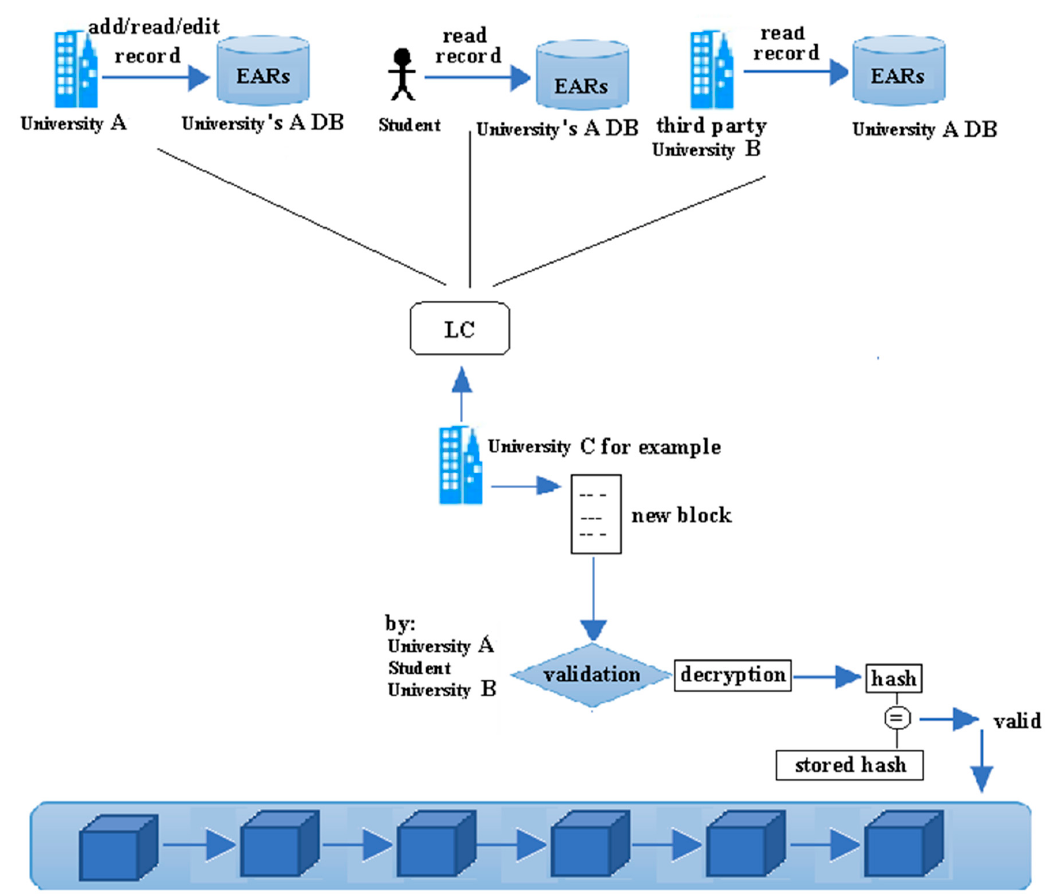
Figure 6. Generating/validating/appending a new block.